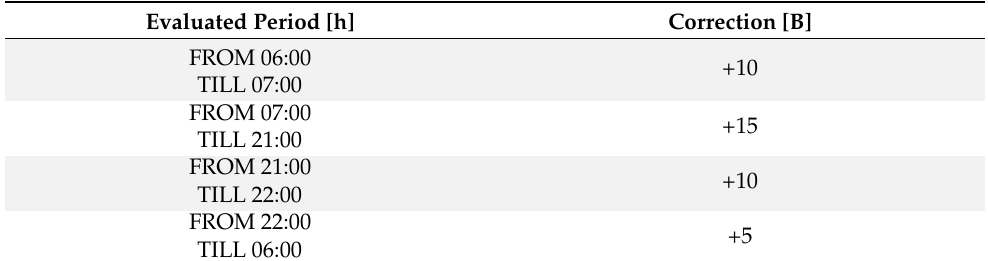
Table 1. Corrections for the setting of hygiene noise limits in protected outdoor areas for noise from construction